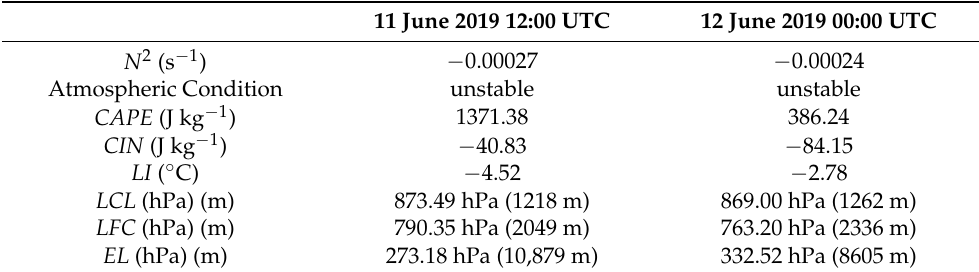
Table 2. Convective parameters of the two radio soundings considered.